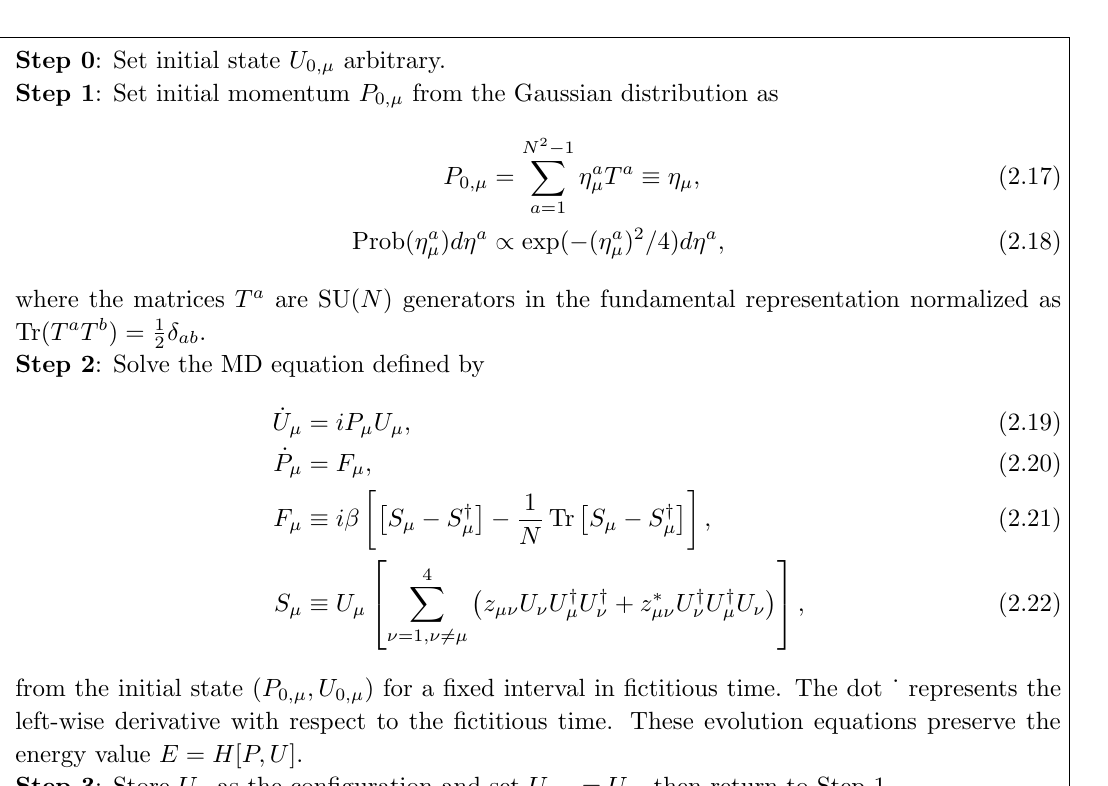
Algorithm 1. HMD algorithm for nonperturbative